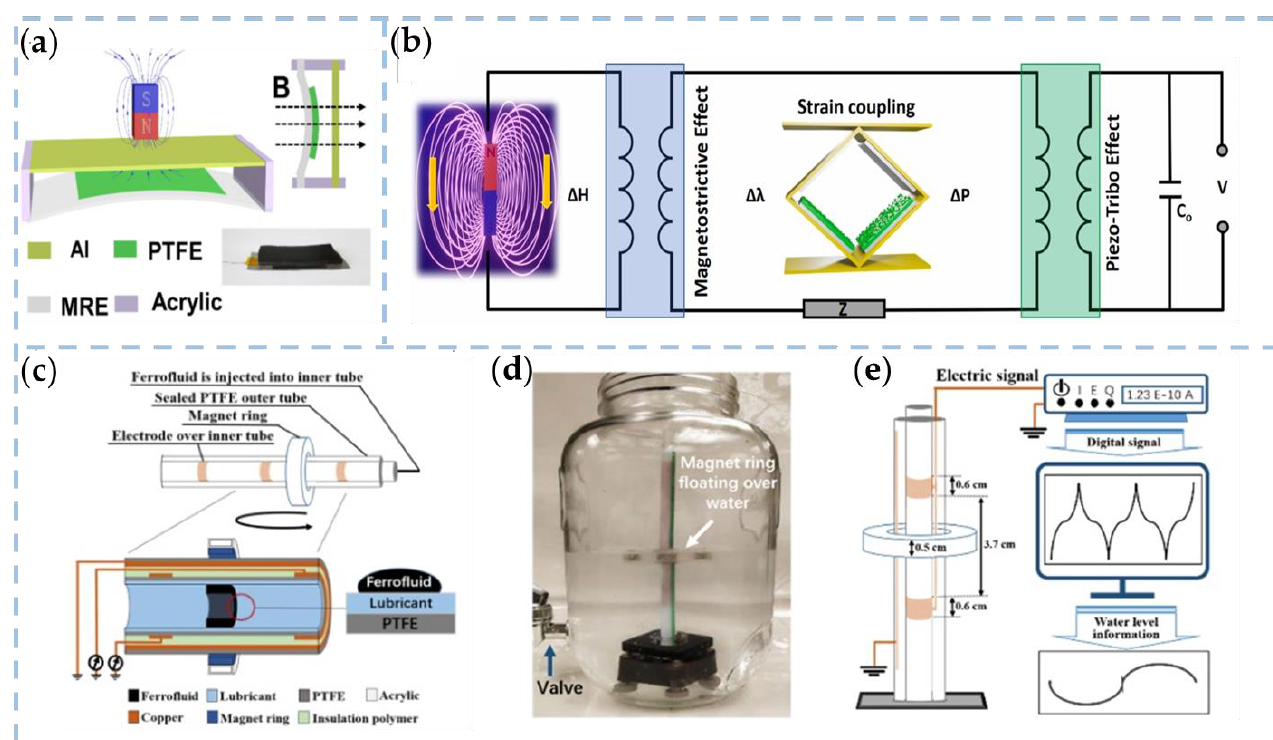
Figure 11. ( a ) The structural design of the MRE-based TENG device [109]. Copyright 2021, MDPI. ( b ) Mechanism of mechano-magnetic and magneto-electric coupling [110]. Copyright 2021, ELSEVIER. ( c ) The schematic of magnetic field assisted non-contact LLI-TENG. ( d , e ) The photograph of LLI-TENG for the water level sensor and the schematic of the detection process [111]. Copyright 2020, ELSEVIER.